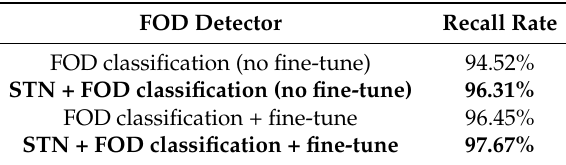
Table 2. The results of